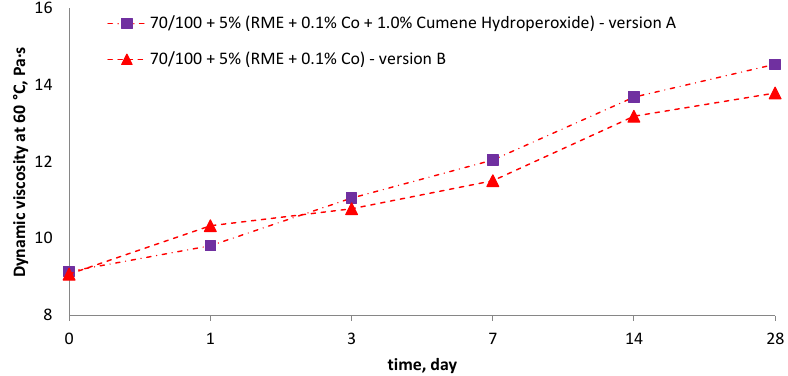
Figure 5. Preliminary tests of reactivity of bio-fluxes in time based on dynamic viscosity test at 60 °C.